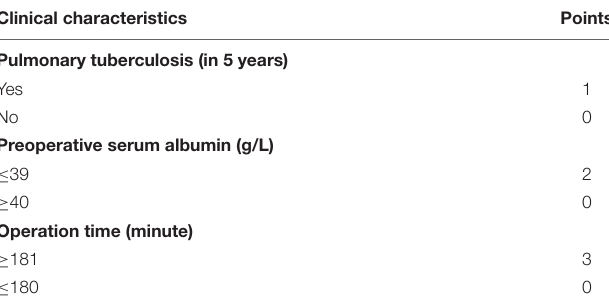
TABLE 5 | Comparison of performance of the scoring scale on derivation set and validation